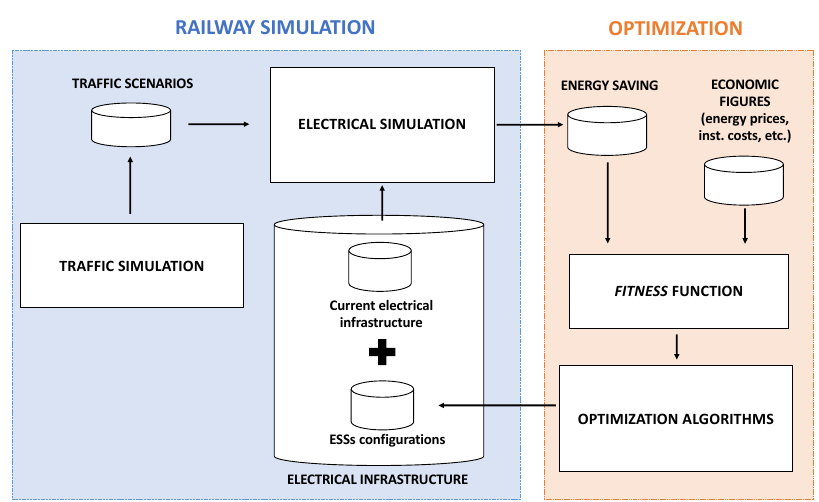
Figure 1. Middleware communicating the railway simulator and the optimization